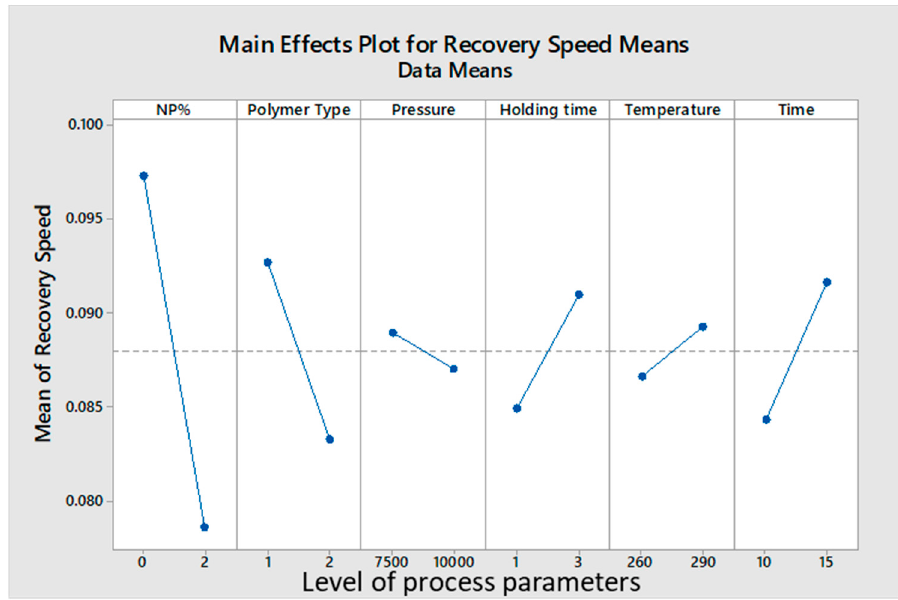
Figure 7. Effect of process parameters on the recovery speed of the samples.